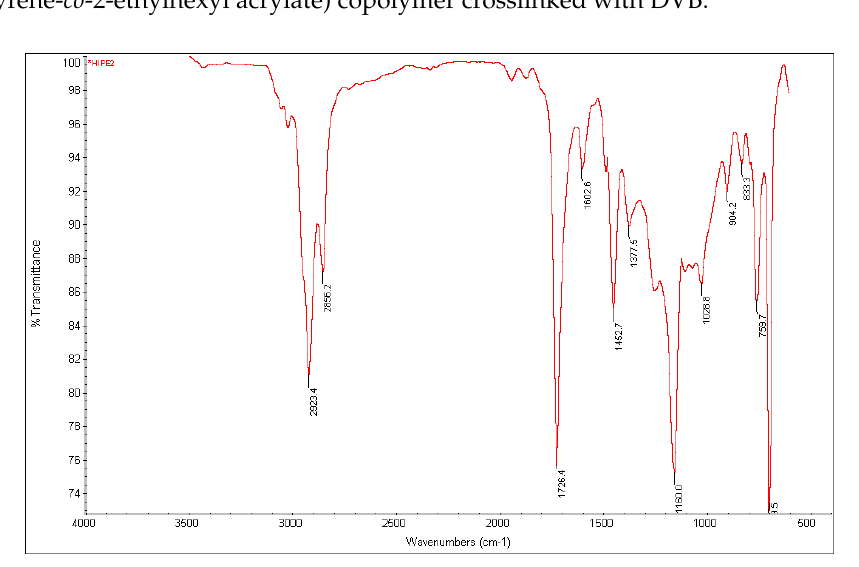
Figure 1. FT-IR spectrum of PolyHIPE membrane (30 wt % styrene (St), 60 wt % 2-ethylhexylacrylate (EHA), and 10 wt % divinylbenzene (DVB)).